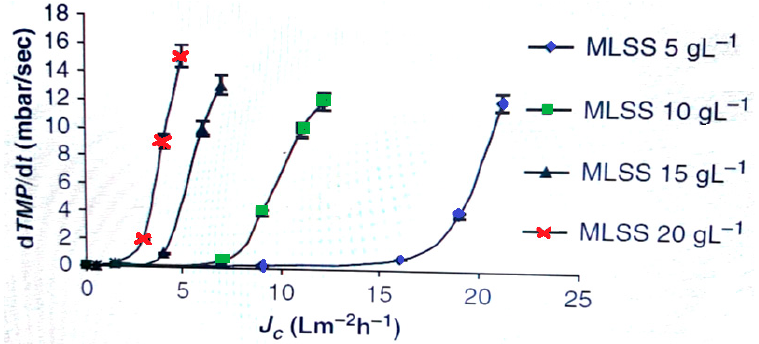
Figure 5. Influence of MLSS concentration on TMP and J of an MBR system during operation [207].